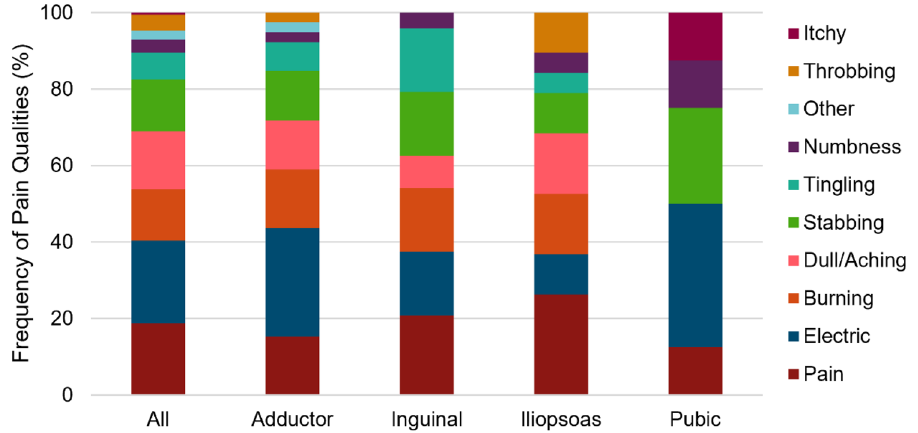
Figure 6. The relative frequency of pain and pain quality descriptors for all athletes (n = 167) and athletes diagnosed with one clinical entity of adductor- (N = 39), inguinal- (N = 24), iliopsoas- (N = 18), or pubic- related (N = 7) groin pain. Color scheme depicts the original color codes utilized by the patients in the drawing